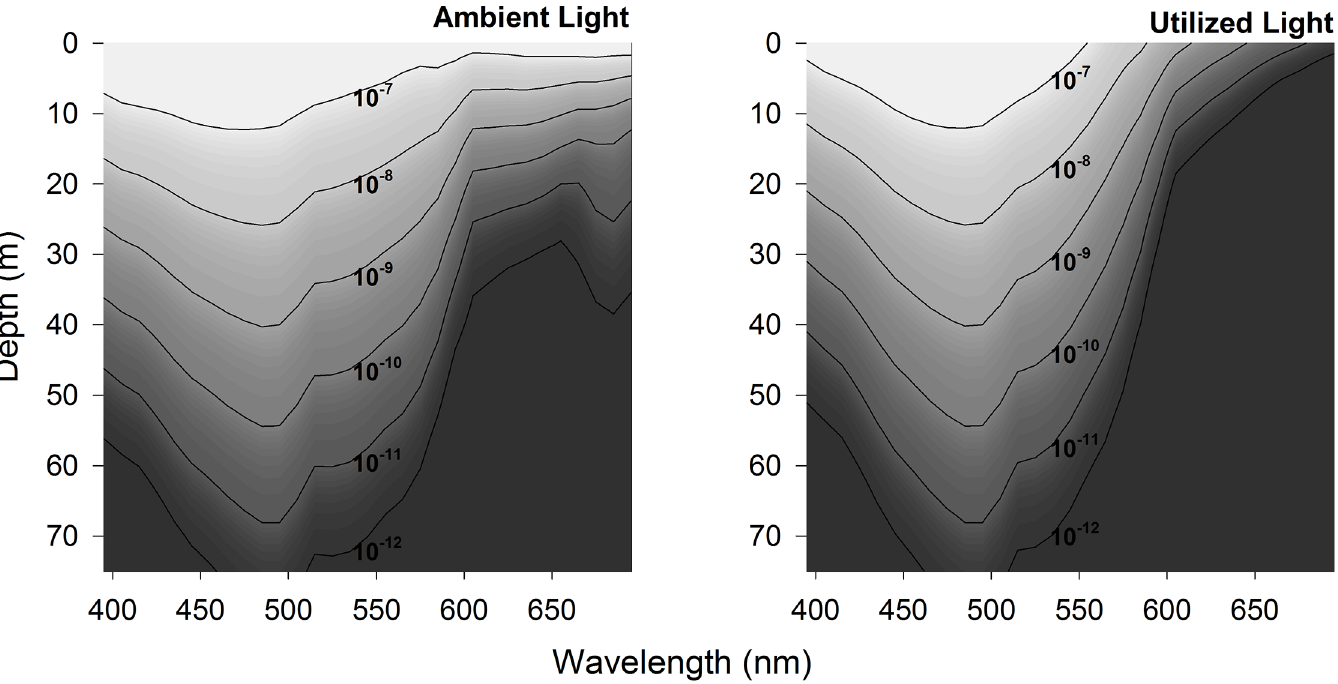
Fig 3. Modelled underwater spectral light field in Kongsfjorden at midday under clear sky conditions. Contours show the ambient underwater light as scalar irradiance (Ambient Light, left panel) and krill-utilized photons (Utilized Light, right panel). For both panels, light is expressed in units of μ mol photons m -2 s -1 nm -1 , derived from a radiative transfer model as described in the Materials and Methods.